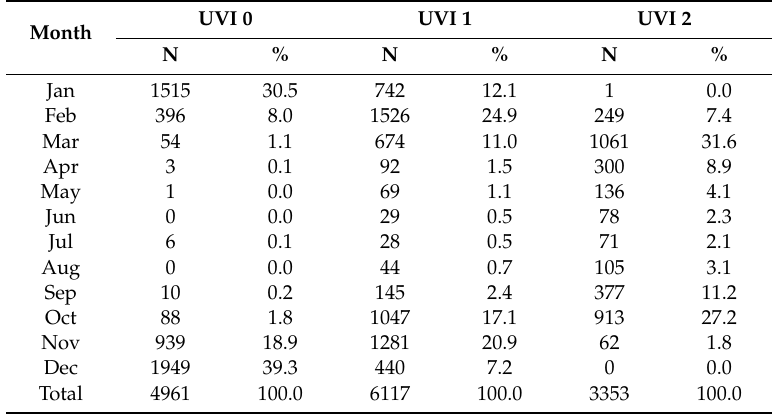
Table 3. Absolute (N) and relative (%) frequency distributions of UVI 0, 1, and 2 days, according to month of